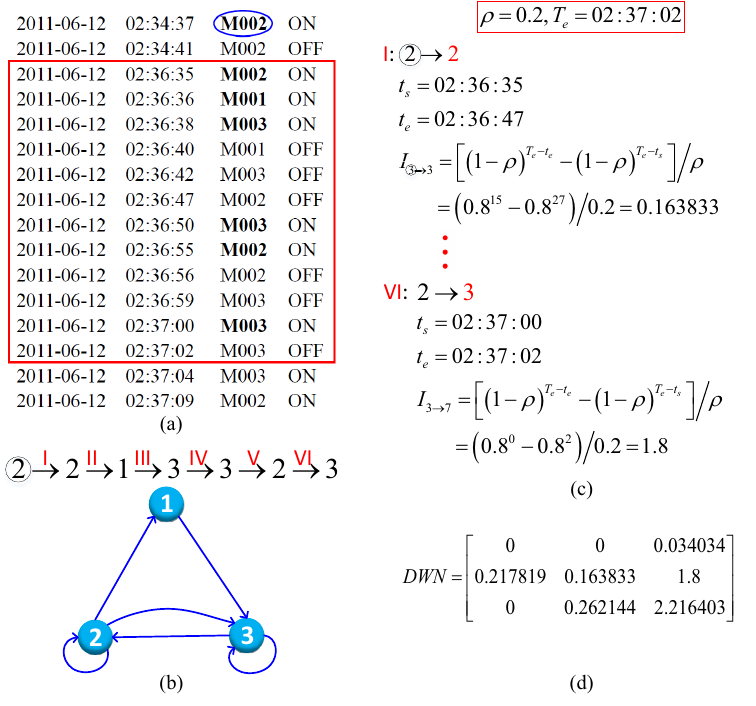
Figure 3. The process from segmented window to DWN. ( a ) Segmented sensor data. ( b ) Directed weighted network. ( c ) Intensity of aggregated pheromone. ( d ) Adjacency matrix of